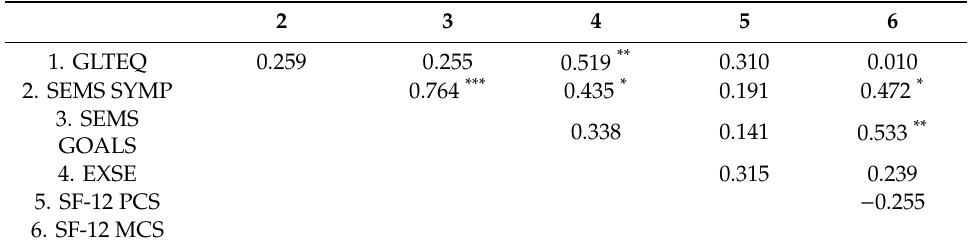
Table 2. Rank-order correlations among the observed variables (Spearman’s